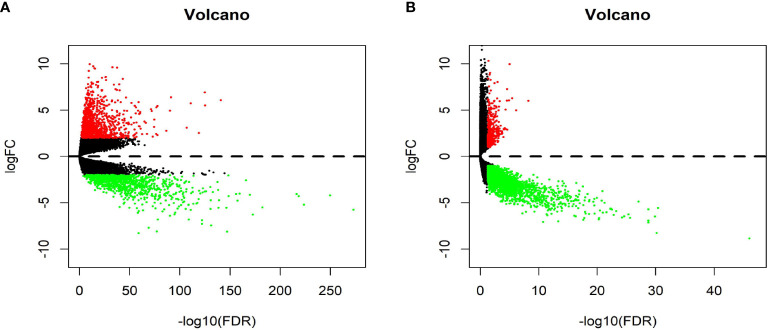
Volcano plot of The Cancer Genome Atlas (TCGA) data. (A) Volcano plot depicting the differential expression and distribution of TCGA-COAD data. (B) Volcano plot depicting the differential expression and distribution of TCGA-READ data.